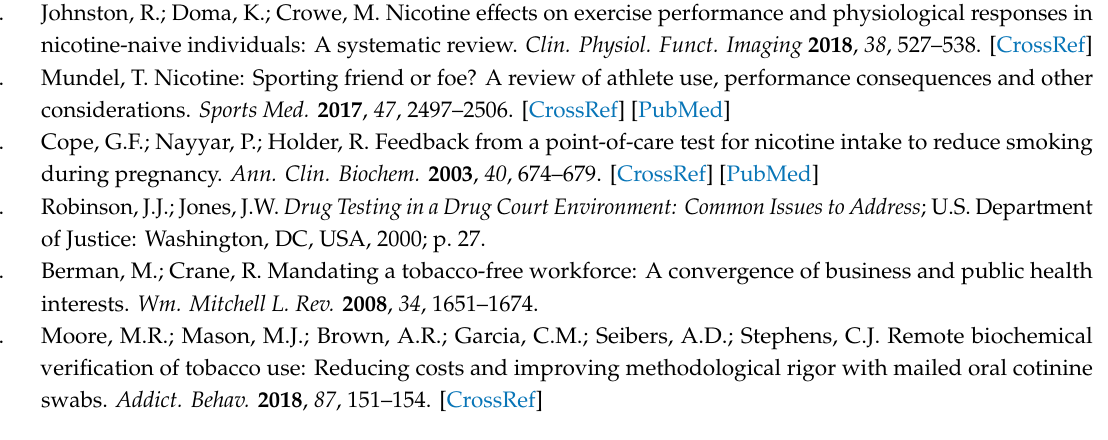
Figure S1: Normal quantile plots of the original and Box-Cox transformed data demonstrating a marginal improvement in data distribution. The Box-Cox transformation value used in the analyses was 0.72433, Table S1: Bland-Altmananalysisusingthevaluesfromimmediateanalysesasthereferencemethod, TableS2: Shapiro-Francia W´ test for normality, Table S3: Skewness and kurtosis tests for